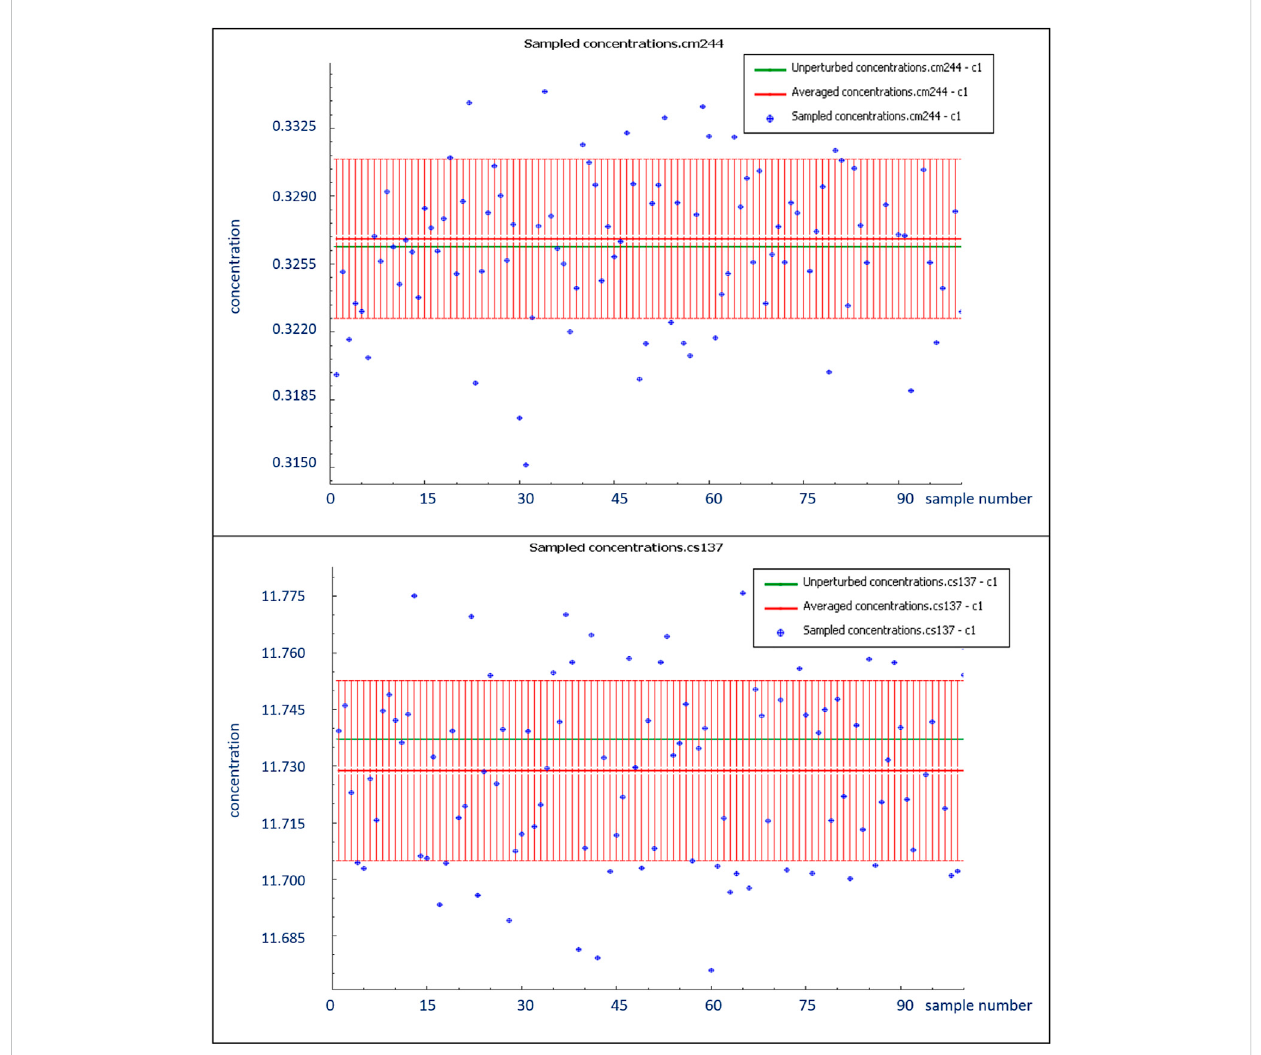
FIGURE 8 Estimating 244 Cmand 137 Csconcentrationuncertainty(relativeunits)frommicroscopicdatawithSCALE ’ sSAMPLERmoduleforarepresentativeUO 2 PWR fuel assembly at 50